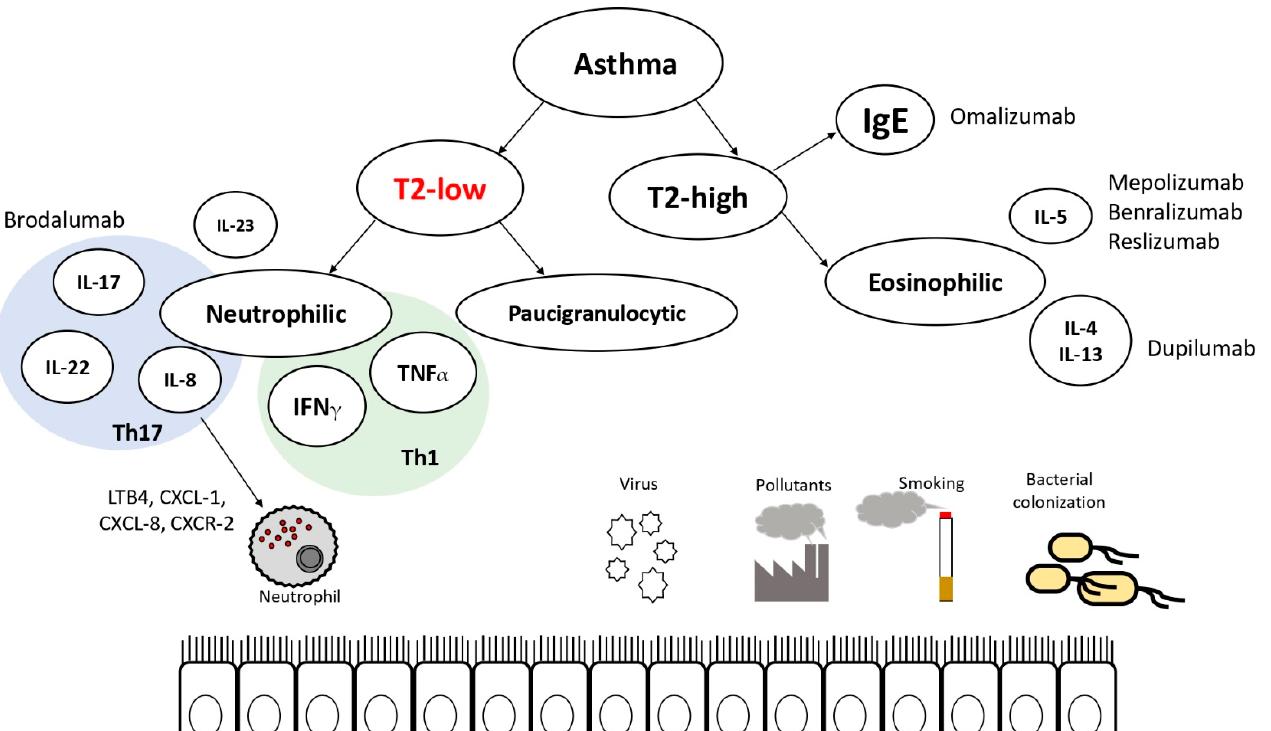
Figure 2. Pathogenesis of T2 high and T2-low asthma: IL: interleukin; TNF: tumour necrosis factor; INF: interferon; IgE immunoglobulin E; LTB4: leukotriene B4, CXCL: chemokine (C-X-C motif) ligand, CXCR: C-X-C motif receptor.